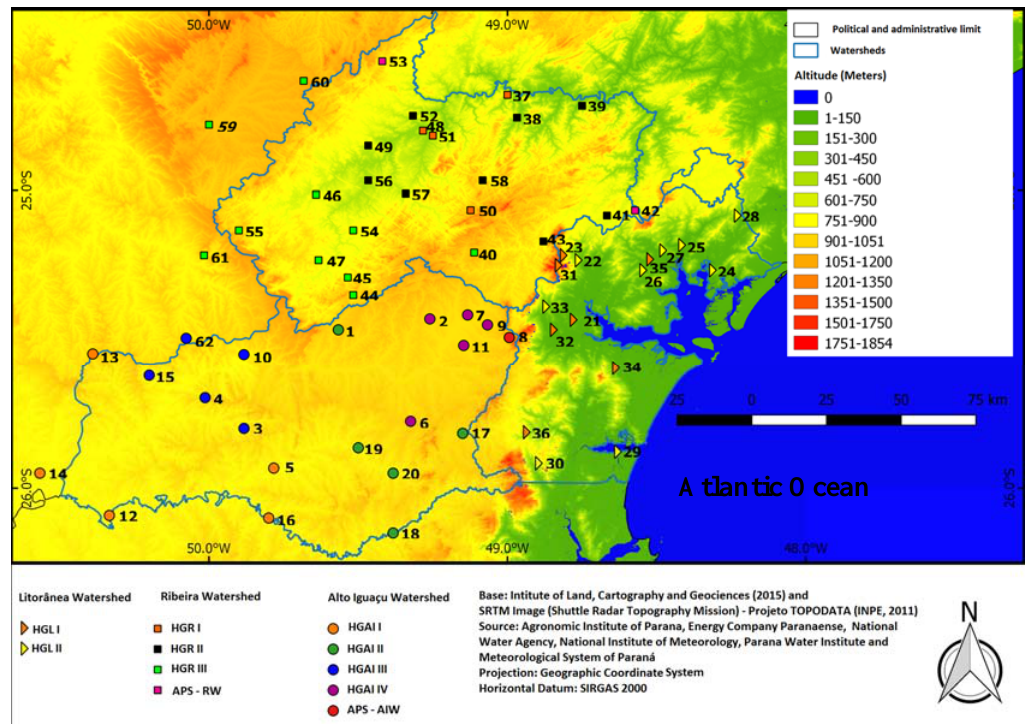
Figure 6. Location of homogeneous groups and anomalous pluviometric stations.